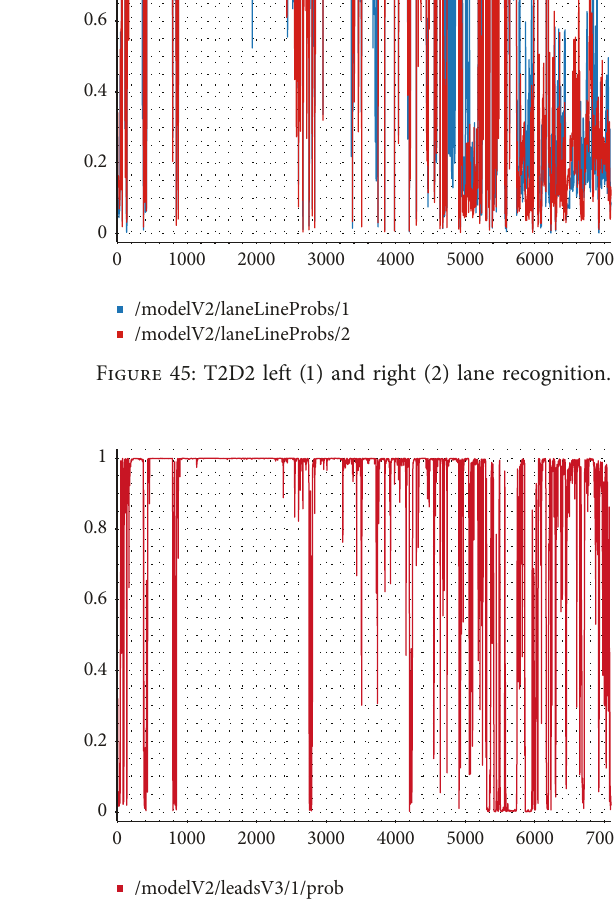
Figure 46: OP steering limitation